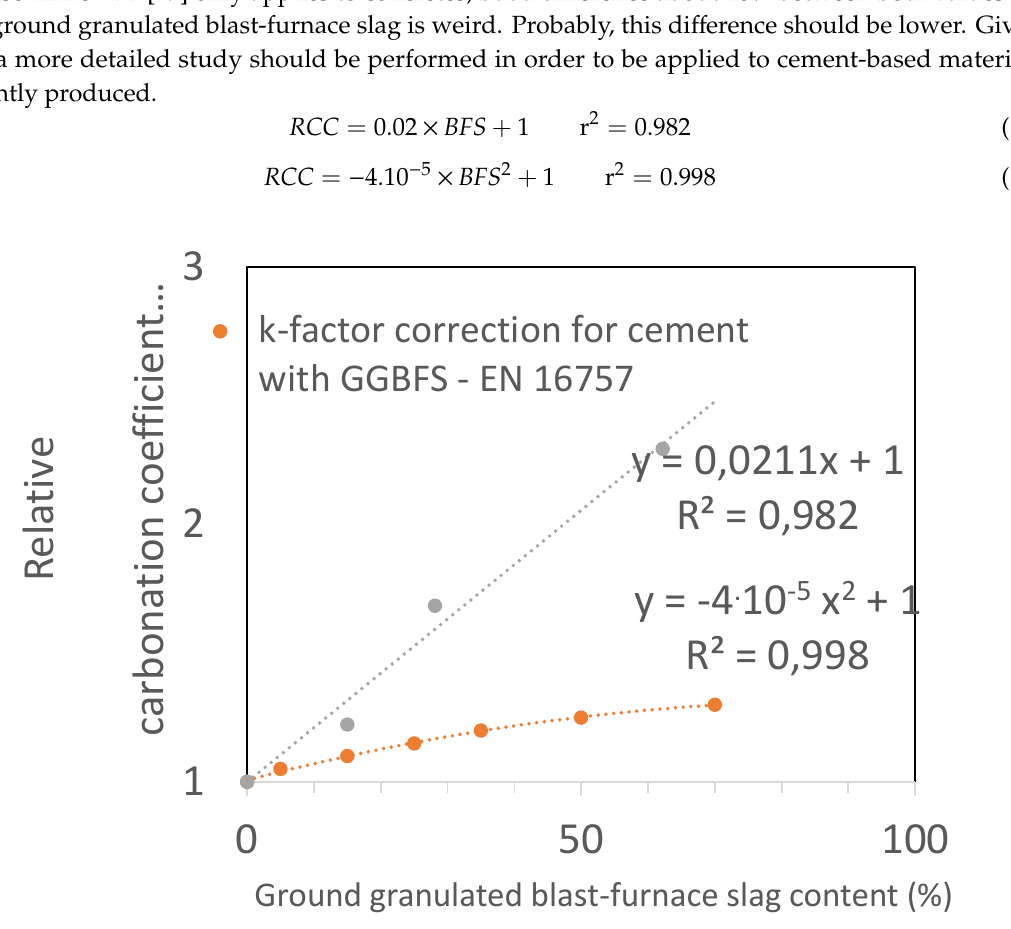
Figure 5. Correction for the k-value for cement with GGBFS according to EN 16,757 [10] in comparison with the relative carbonation coefficient of mortars made with GGBFS (0, 14.4, 28.1, and 62.2%) and cured underwater for 28 days.